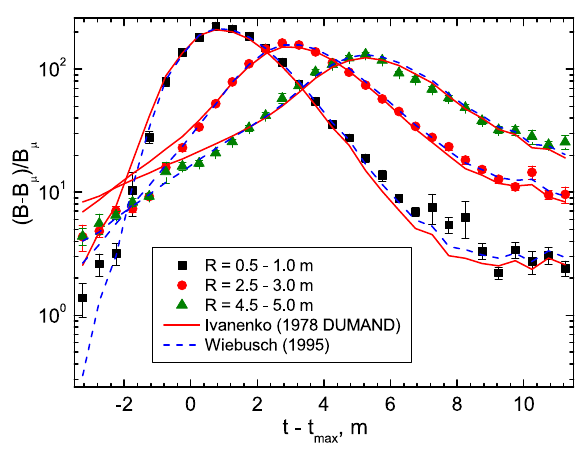
Figure 2. Longitudinal profiles of spatial distribution of the Cherenkov radiation from